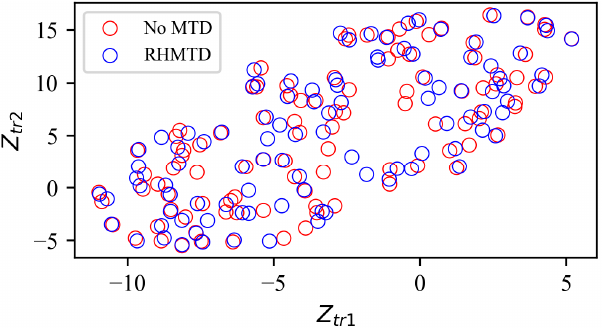
Figure 10. The projection of RHMTD, 10 RMTD, and no MTD measurements in the ℝ 2 space.